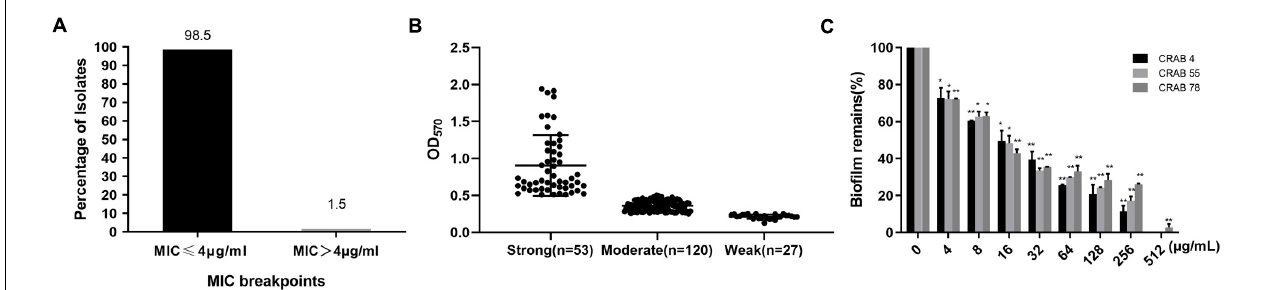
FIGURE 1 | Cec4 inhibits clinical resistant bacteria and biofilms. (A) Distribution of MIC value of Cec4 against 200 CRAB clinical isolates ( µ g/mL). (B) Quantification of biofilm formation in 200 CRAB clinical isolates. A. baumannii ATCC19606 was used as a positive control. Experiments were performed in triplicate and each bar represents the mean ± standard deviation. (C) The effects of Cec4 on mature biofilms of CRAB. The adherent biofilm was stained by crystal violet, and then the dye was extracted with ethanol, measured at a 570-nm absorbance, and presented as percentage of biofilm remains compared to untreated wells (0 µ g/mL). All experiments were done in triplicate for statistical significance. * p < 0.05; ** p < 0.01.